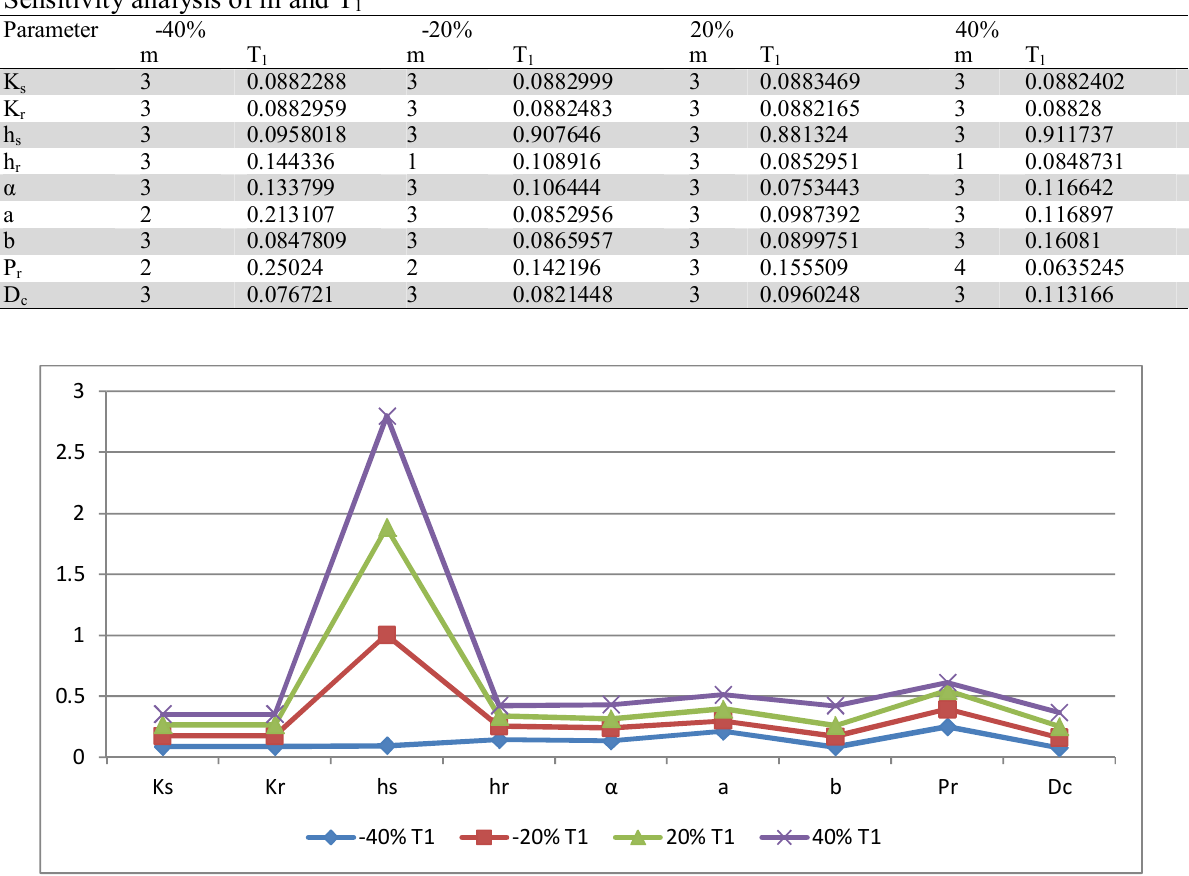
Sensitivity analysis of m and T